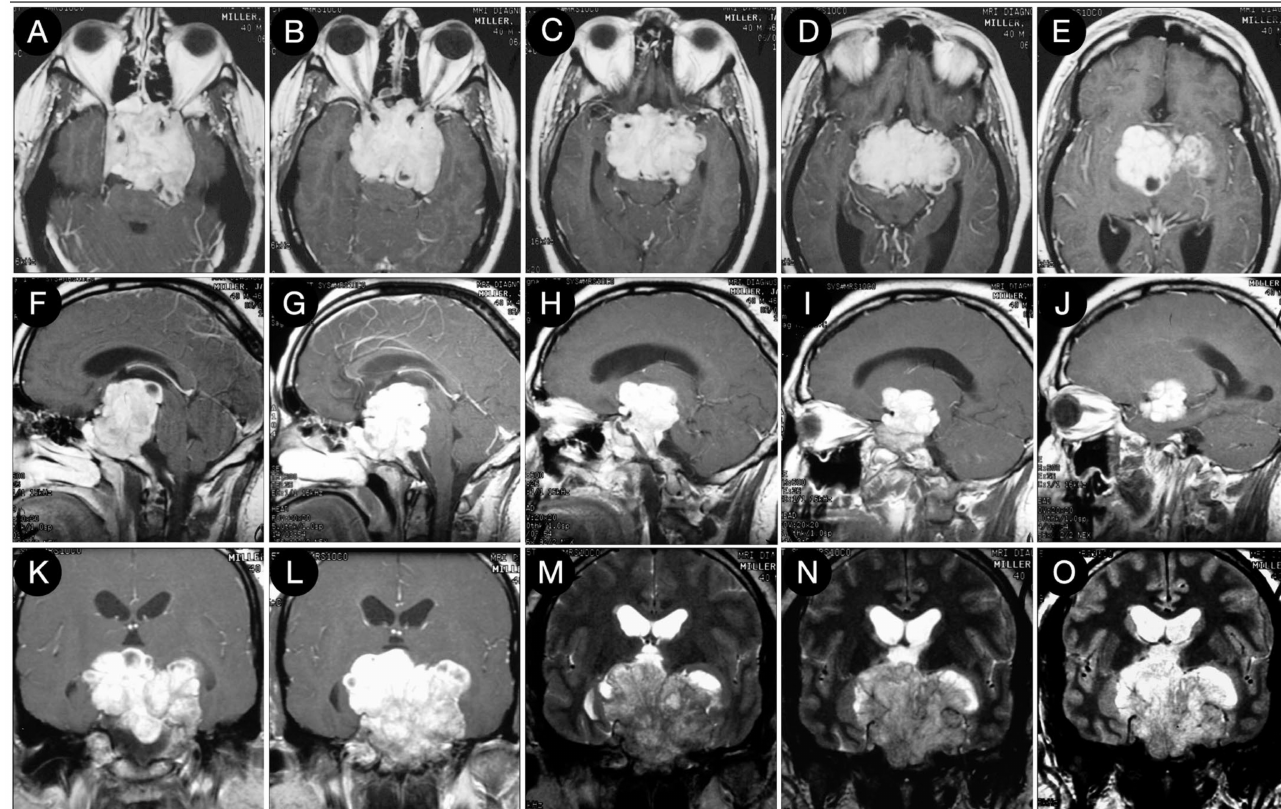
Figure 3. Preoperative axial ( A – E ), sagittal ( F – J ), and coronal ( K – O ) T1-weighted contrast-enhanced MRI. Scale bar: 5